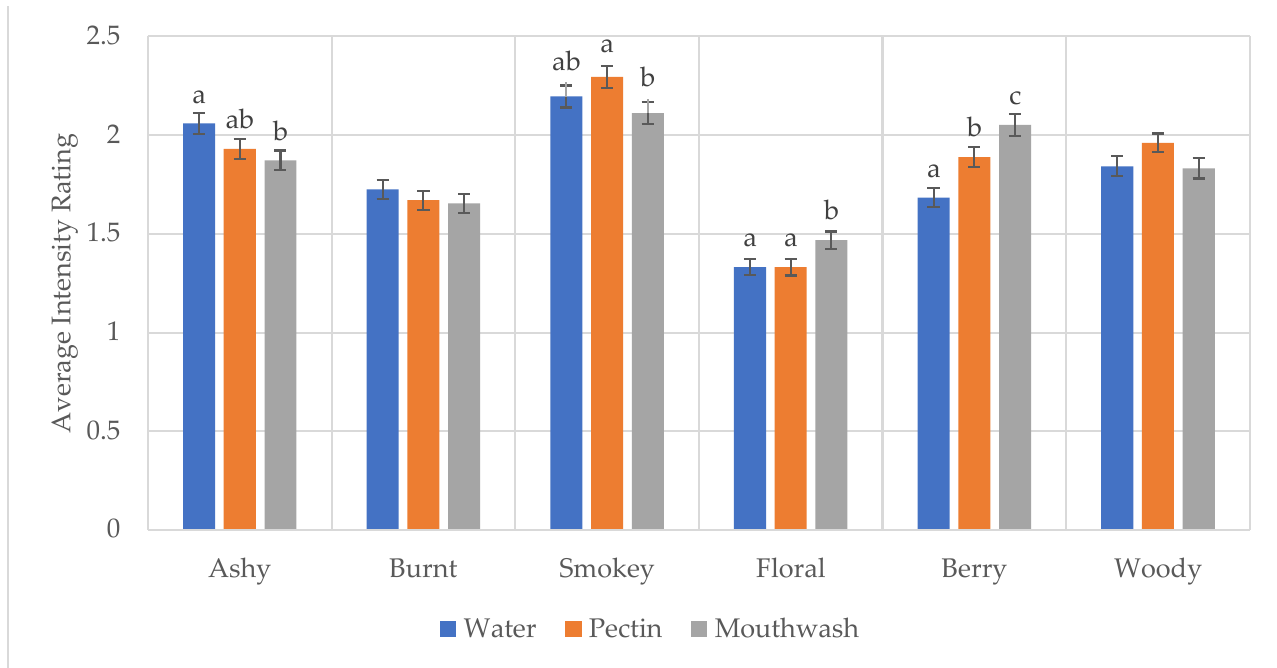
Figure 4. Average intensity over all wines and times for water (blue), pectin (orange), and mouthwash (grey). The same letters above bars indicate no statistical difference within each attribute as determined by Tukey HSD comparison of means at a 95% confidence level. Error bars represents standard error of the means.